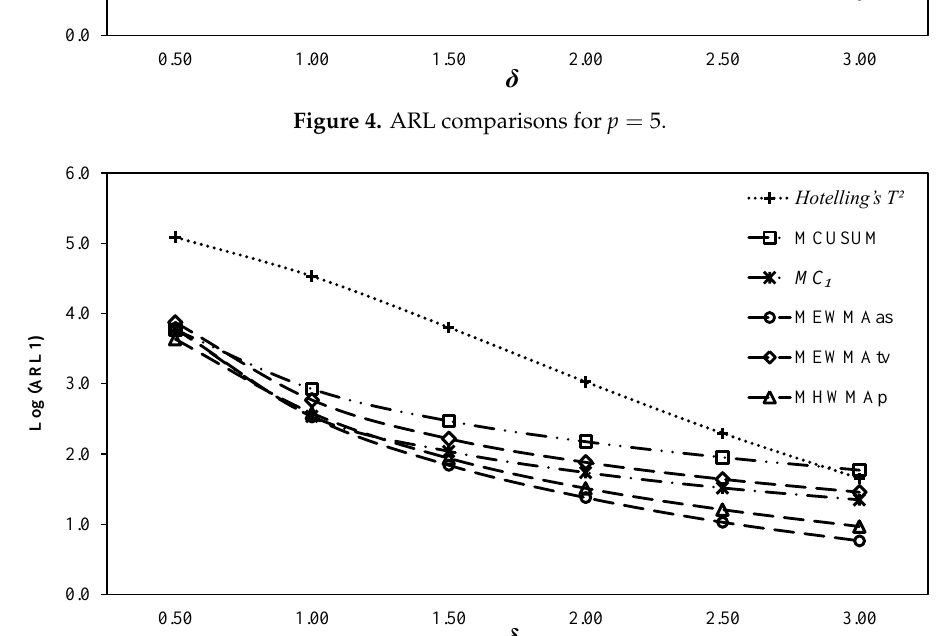
Figure 4. ARL comparisons for p = 5. Mathematics 2020 , 8 , x FOR PEER REVIEW Figure 4. ARL comparisons for 𝑝 = 5 . Figure 4. ARL comparisons for 𝑝 = 5 .